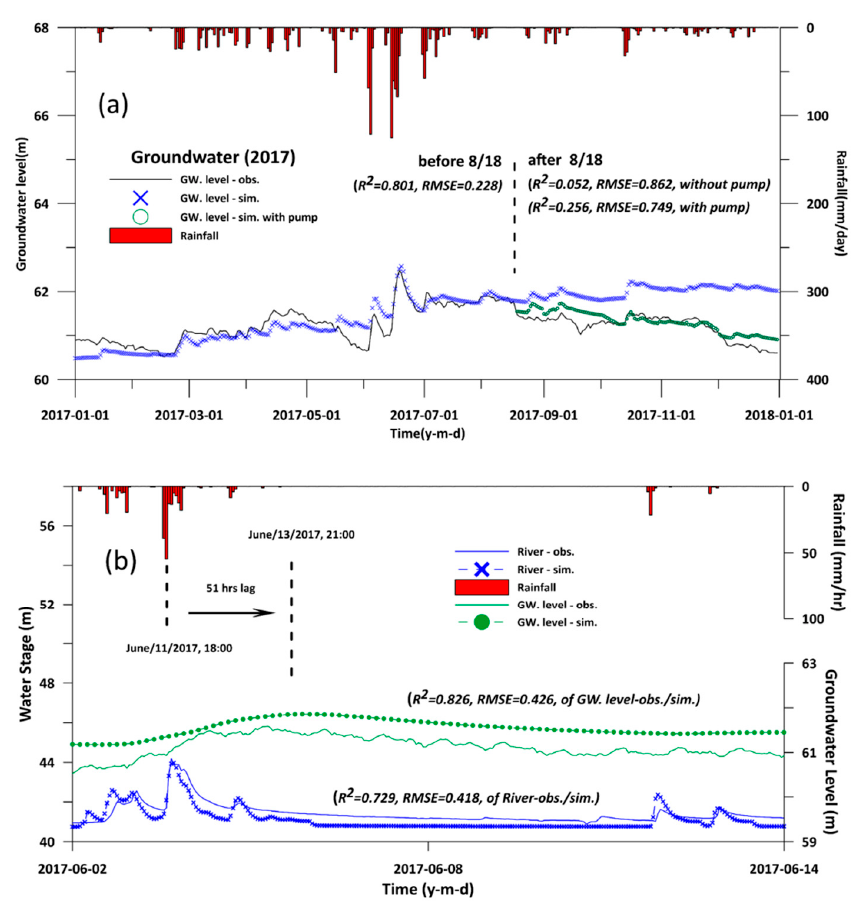
Figure 6. ( a ) Validation results for groundwater level in 2017; ( b ) rainfall-induced flow hydrographs of surface water and groundwater from 2 June to 14 June in 2017, where the scale is 5× magnification in the z -direction.